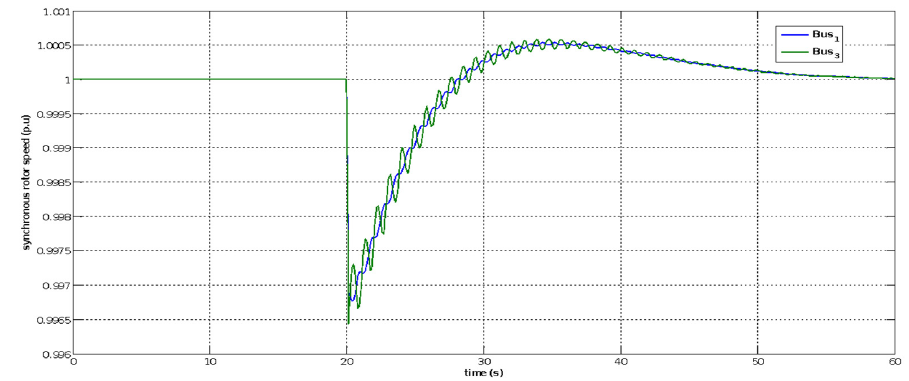
Figure 48. Rotor speed response of generators at swing bus 1 and bus 3 under a three ‐ phase short circuit at bus 15 with STATCOM.